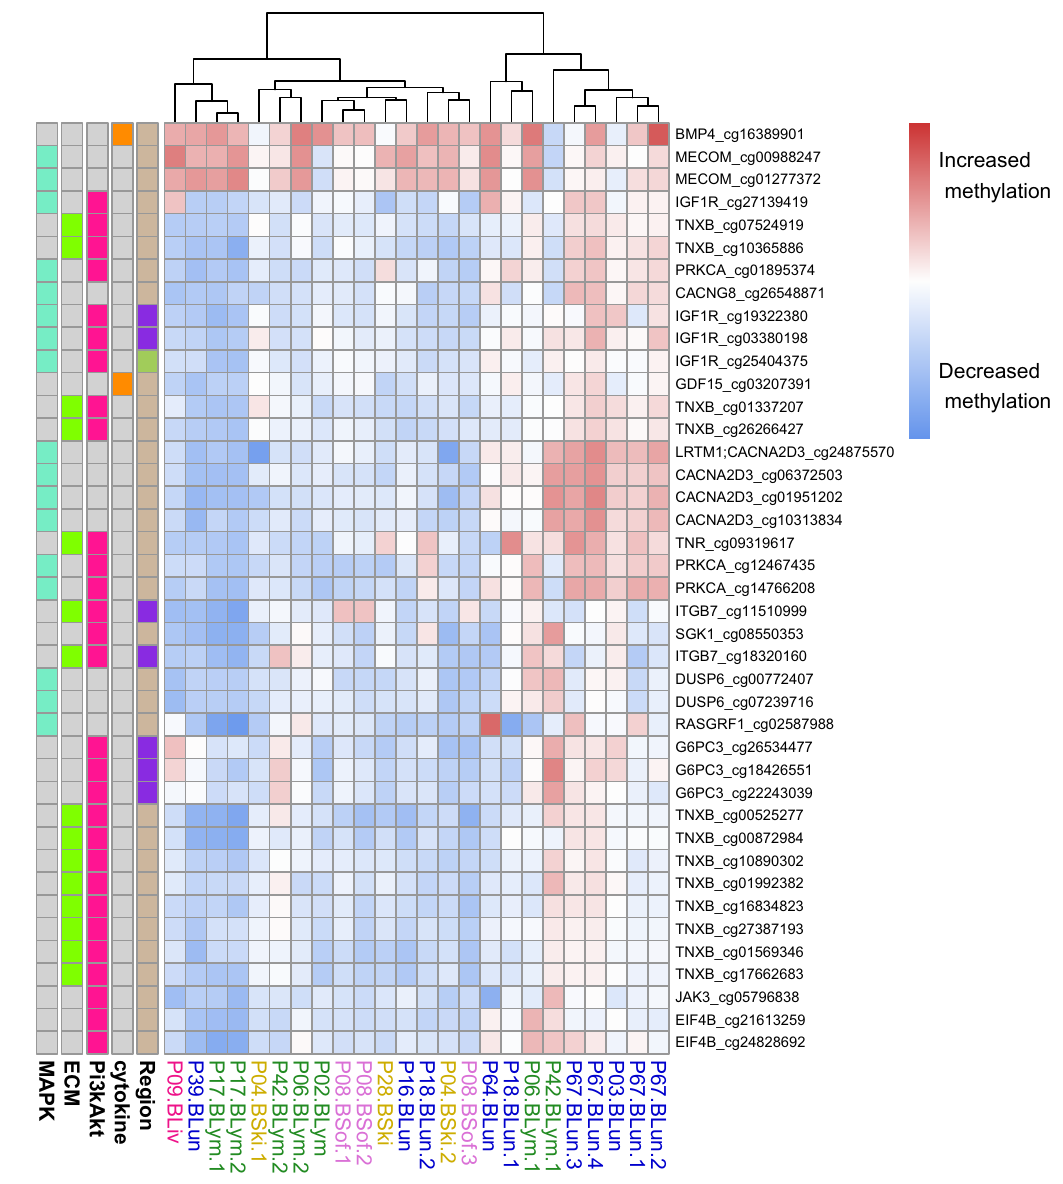
Figure 6. Heatmap of log 2 -ratios of methylation levels of CpGs associated with the 17 signaling pathway gene candidates that best distinguish intra- and extracranial melanoma metastases. The log 2 -ratios quantify the methylation changes in the intra- compared to the corresponding extracranial metastasis for each patient- matched metastases pair. Color coding of the sample names below the columns of the heatmap represents the tissues in which the extracranial metastases occurred (blue: lung, green: lymph node, yellow: skin, purple: soft tissue, pink: liver). Gene names associated with individual CpGs are shown along the rows at the right side of the heatmap. The gene names are further extended by the underlying CpG identifiers. The location of each CpG relative to its associated gene are displayed at the left side of the heatmap along the rows distinguishing between promoter (purple), gene body (brown) or enhancer (green) regions. Specific pathway memberships of the candidate genes are also shown at the left